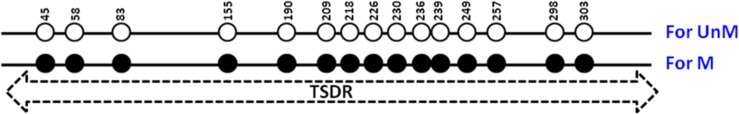
Human TSDR of FOXP3. Schematic illustration of the amp-5 region of human TSDR of FOXP3 is showing the position of the 15 CpG sites. Solid circles represent methylated CpGs and open circles represent unmethylated CpGs. UnM, unmethylated; M, methylated.